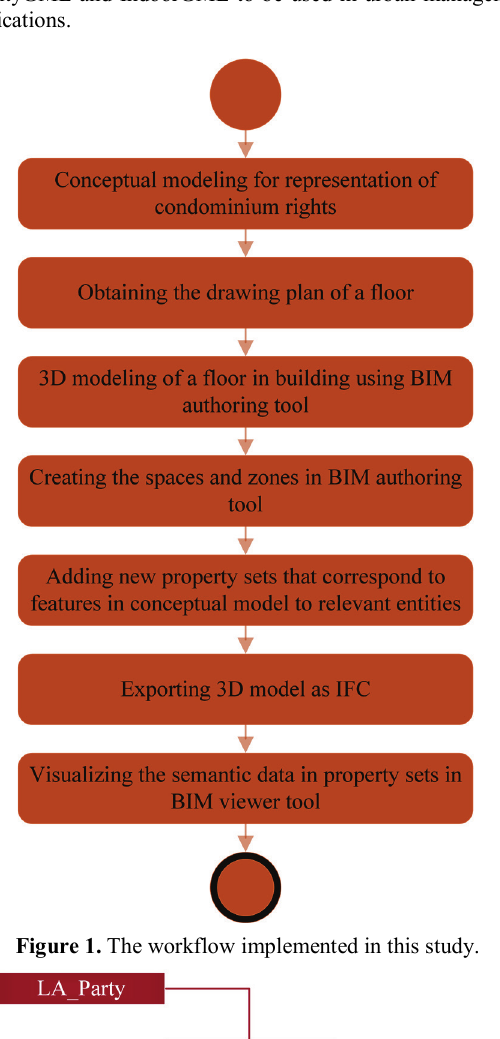
Figure 1. The workflow implemented in this study.